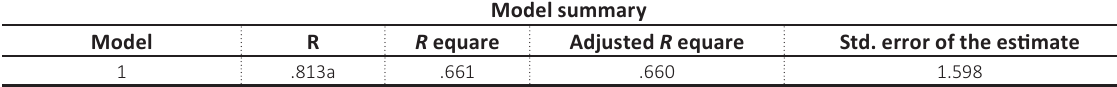
Table 5. The result of multiple regression analysis for hypothesis testing